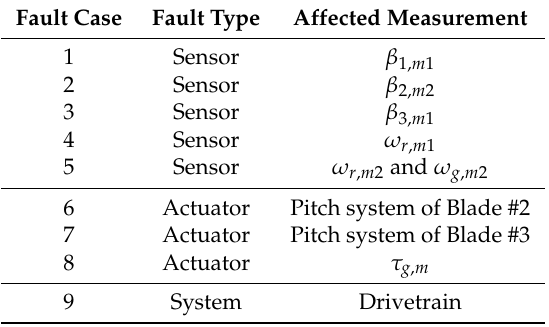
Table 1. Fault scenario of the wind turbine